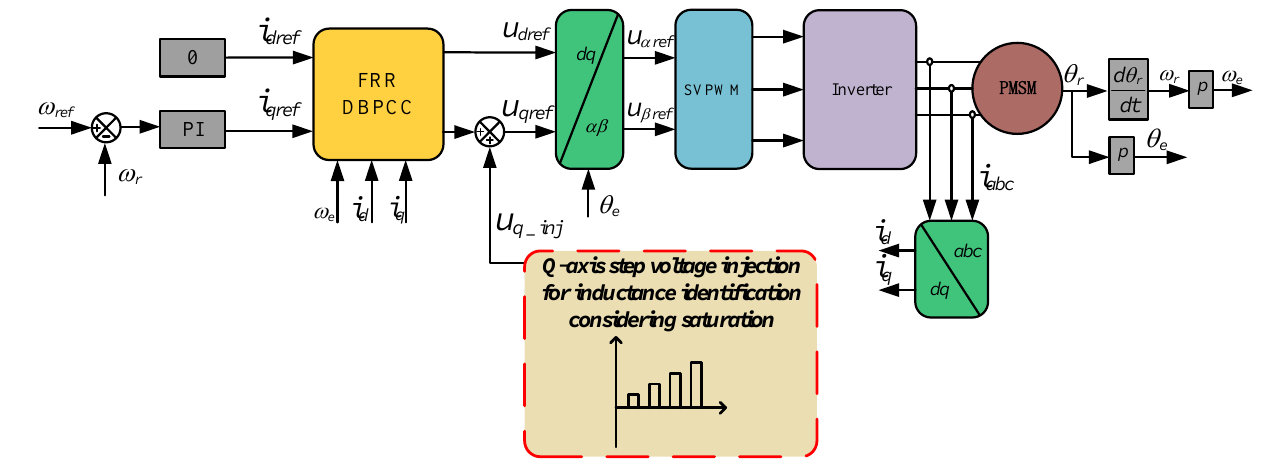
Figure 2. Block diagram of the proposed method.